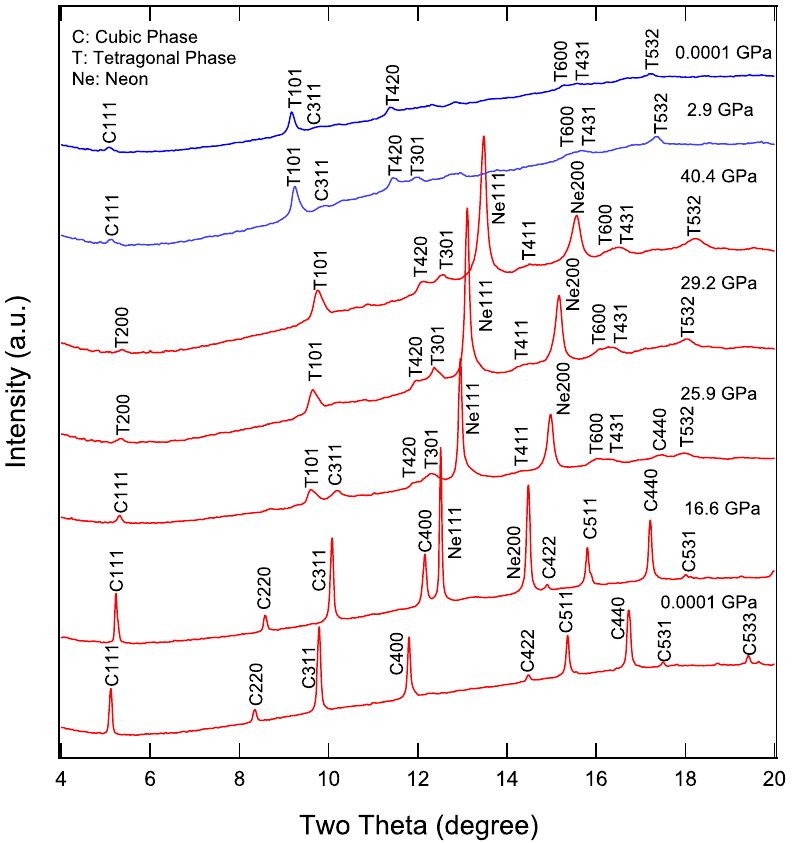
Figure 6. Representative X-ray diffraction patterns of Mg 2 TiO 4 collected in Run 3. Cubic Mg 2 TiO 4 spinel fully transforms to tetragonal structure at 29.2 GPa. Upon decompression, both low- and high-pressure phases were present at ambient pressure. The room-pressure pattern was collected after 24 hours of decompression. (Red: compression patterns; blue: decompression patterns).